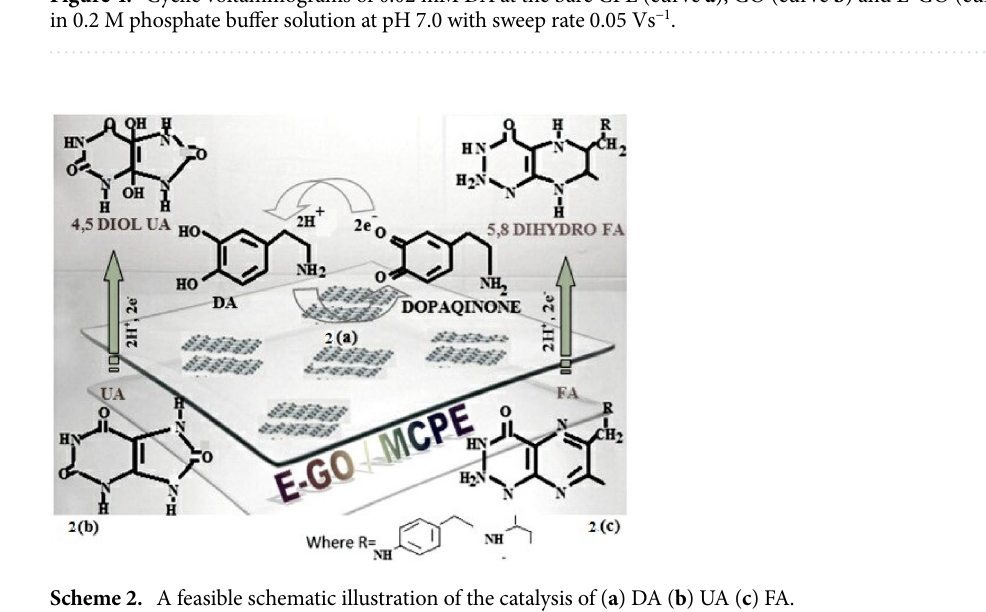
Scheme 2. A feasible schematic illustration of the catalysis of ( a ) DA ( b ) UA ( c )